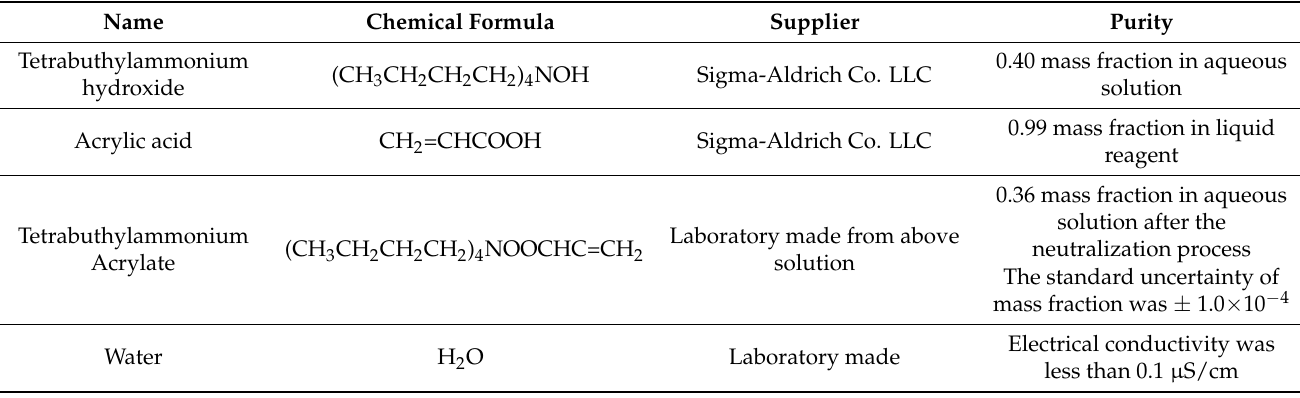
Table 1. Specification of the reagents used in this